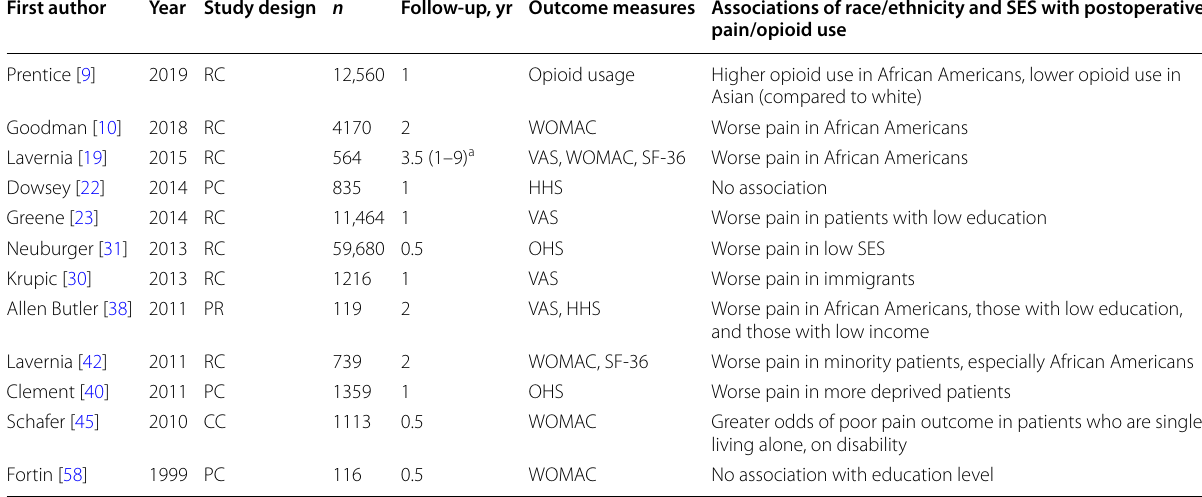
CC Case–control, CI Confidence interval, HHS Harris Hip Score, OHS Oxford Hip Score, OR Odds ratio, PC Prospective cohort, PR Prospective randomized, RC Retrospective cohort, SES Socioeconomic status, SF-36 36-Item Short-Form Health Survey, THA Total hip arthroplasty, VAS Visual analog scale, WOMAC Western Ontario and McMaster Universities Arthritis Index a Data presented as mean